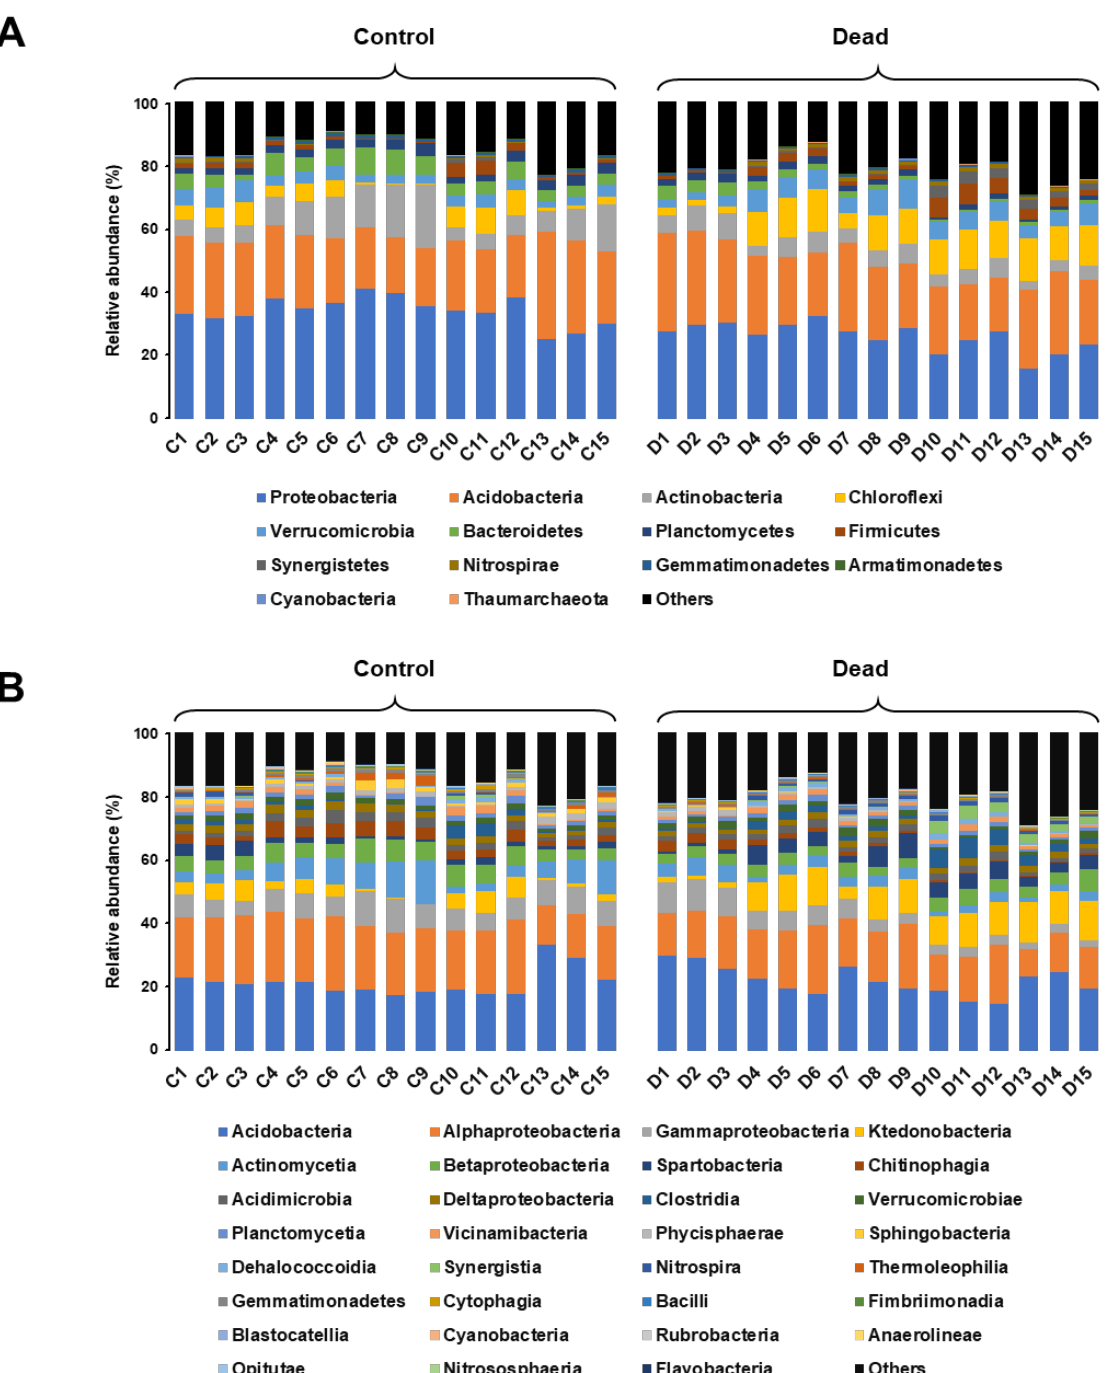
Figure 4. Stacked bar graphs representing the microbiota structure of Korean fir tree rhizospheres at ( A ) the phylum and ( B ) the class levels. The samples are representative of the healthy control and standing dead trees.